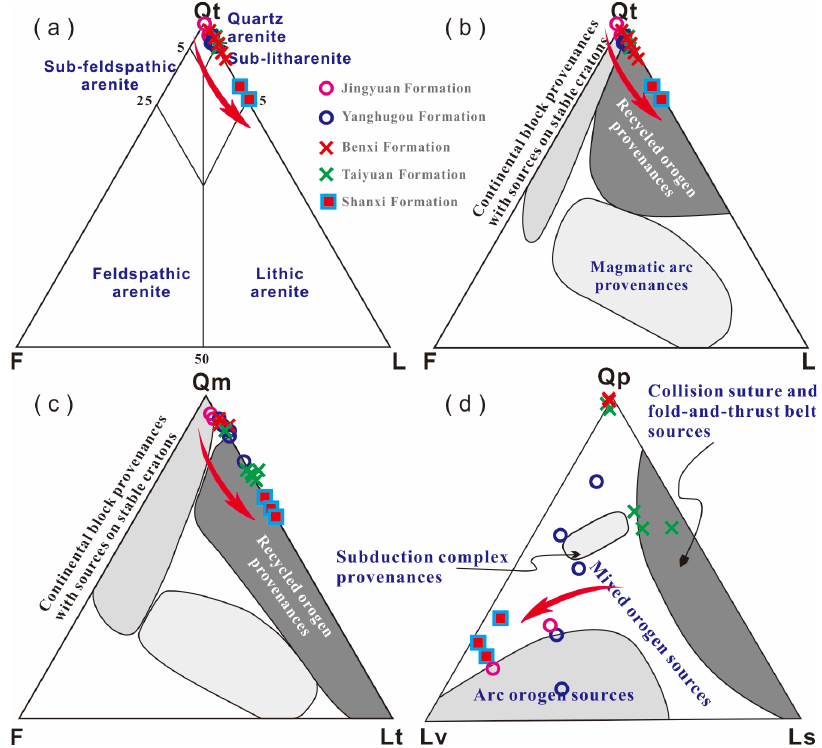
Table 1. Petrography and sample location of sandstones for zircon U–Pb age dating.